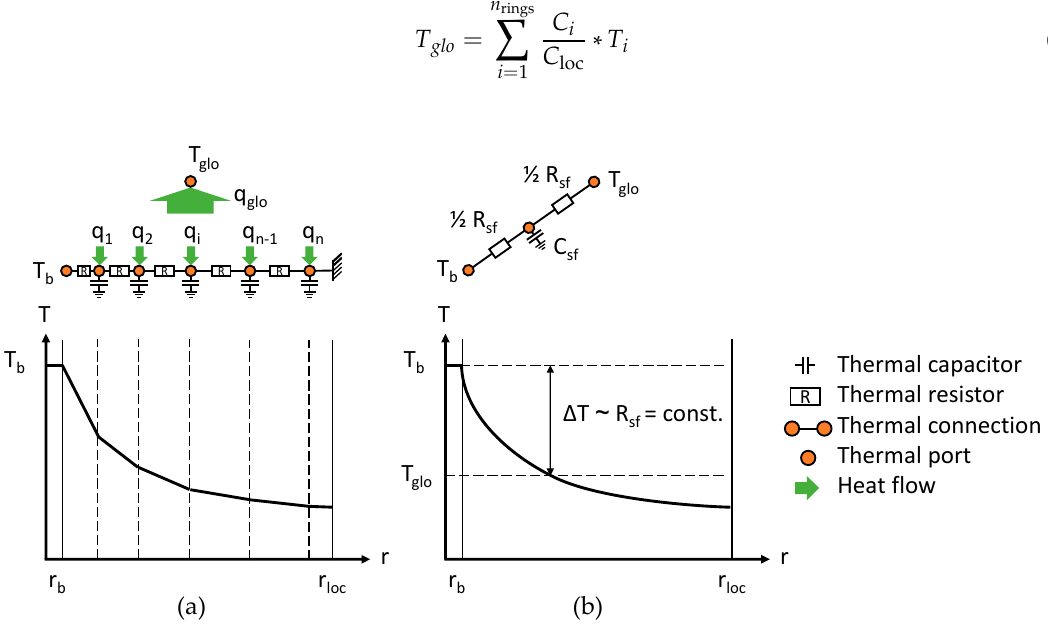
Figure 2. Local model concepts: ( a ) finite di ff erences model and ( b ) steady flux model.